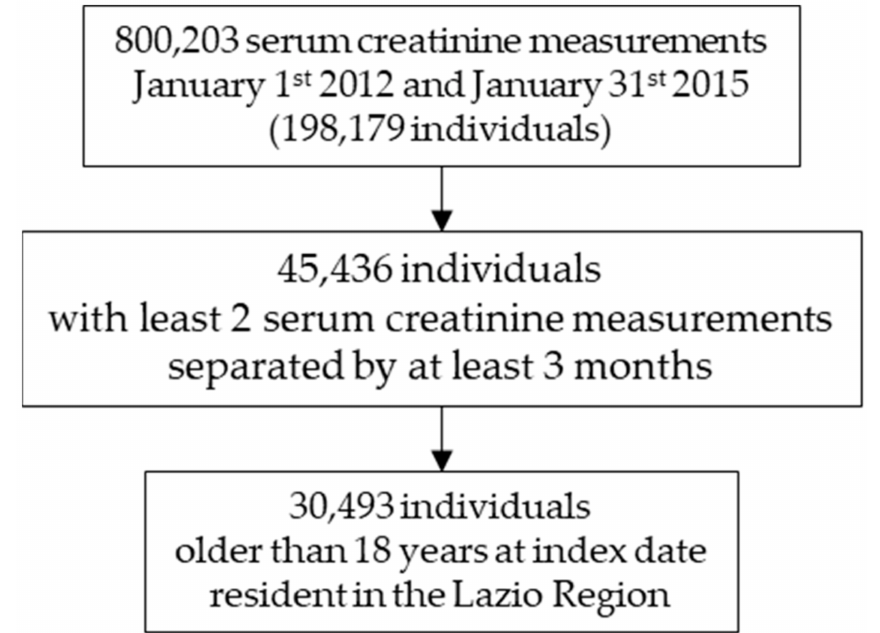
Figure 1. Flow-chart of study population